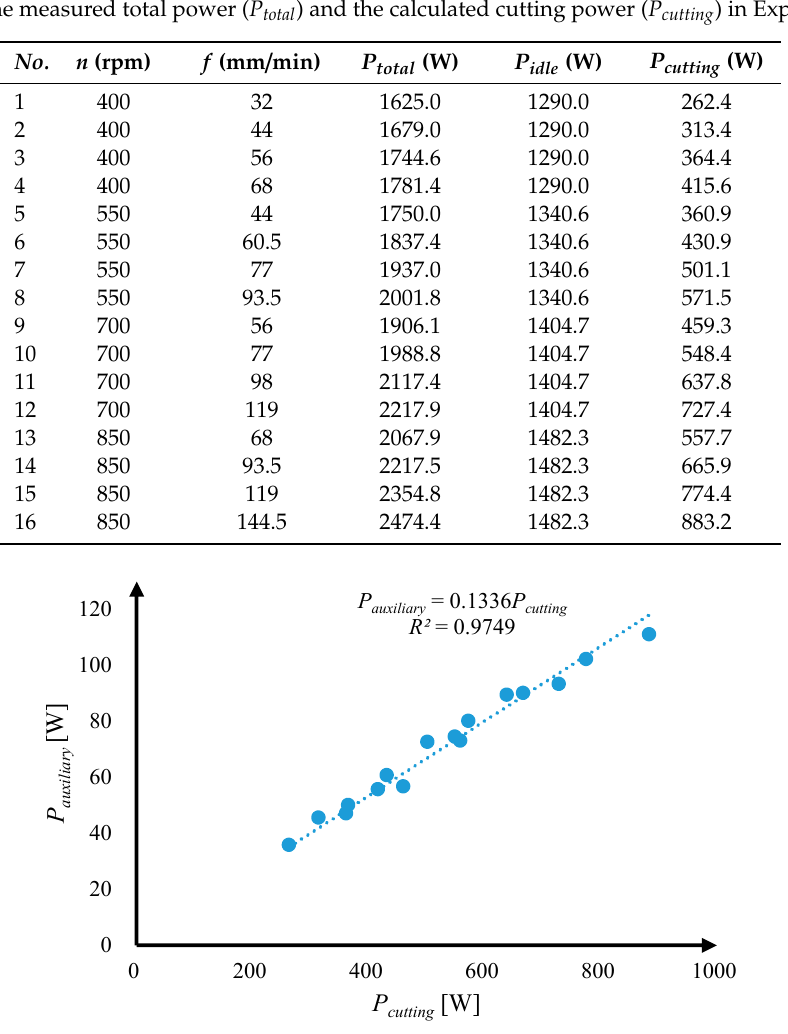
Figure 6. The auxiliary power at different cutting powers.